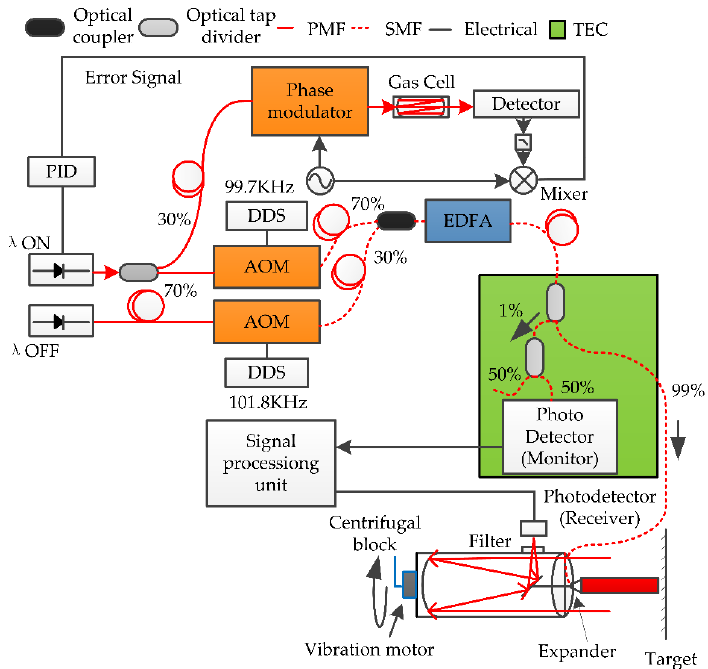
Figure 10. The improved system configuration. The green box represents the thermal control function, and a vibration motor is installed behind the telescope.